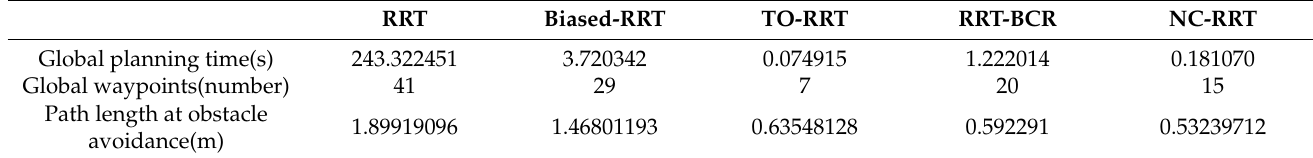
Table 6. Experimental data using